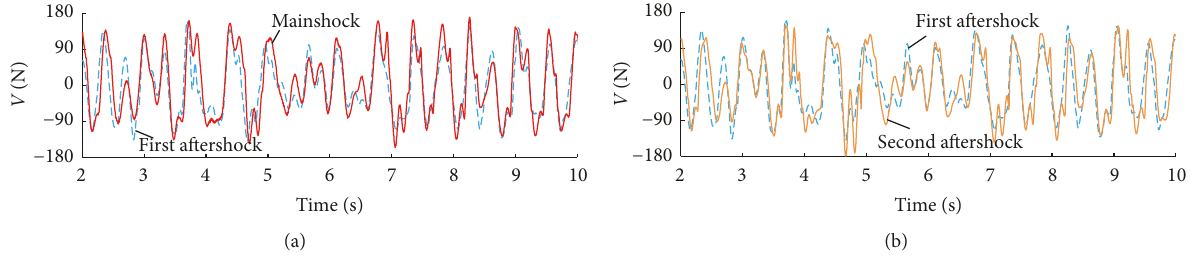
Figure 16: Base shear in the structure due to the mainshock and aftershocks.